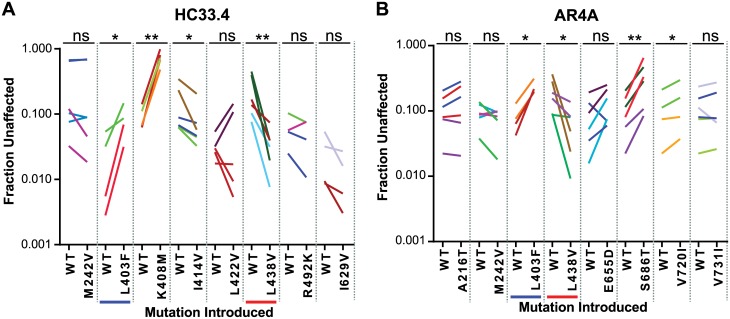
Site-directed mutagenesis confirms multiple SNAPR-predicted resistance polymorphisms.Putative resistance polymorphisms were introduced by site-directed mutagenesis into multiple distinct wild type (WT) E1E2 variants in which they were not naturally present. These WT variants were each from subtype 1a and differed from each other prior to mutagenesis by an average of 42 amino acids (7%). WT and mutated E1E2 variants were used to produce HCVpp, which were tested for neutralization by 10 μg/mL of HC33.4 (A) or AR4A (B). Fraction unaffected is the infection in the presence of 10 μg/mL of neutralizing antibody/infection in the presence of nonspecific IgG. Each mutation was introduced into 2–3 distinct E1E2 variants and neutralization effect of each mutation was tested in at least 4 independent experiments performed in duplicate. Each line indicates an independent experiment comparing a WT HCVpp to the corresponding mutant version, and different colors indicate different E1E2 variants. WT HCVpp and corresponding mutant HCVpp neutralization were compared by paired, two-sided T test. (ns, not significant; *, p<0.05; **, p<0.005).